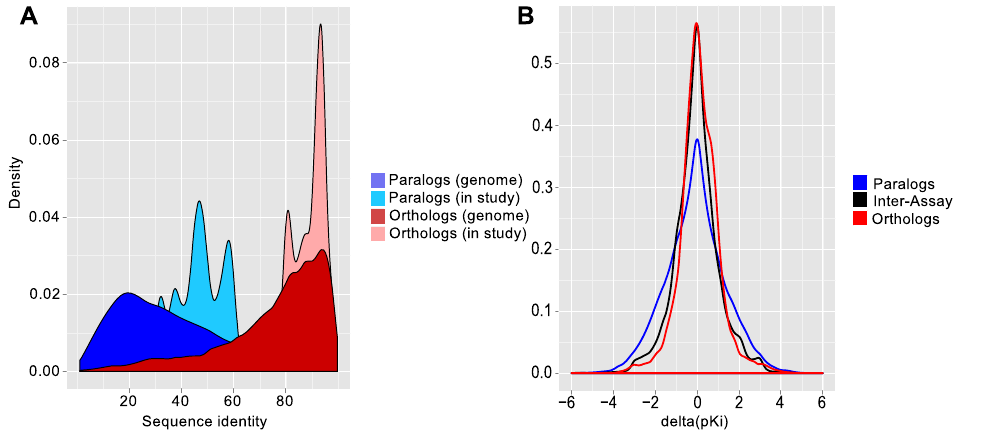
Figure 2. (a) Distributions of pairwise sequence identity between orthologs (red) and paralogs (blue). Distributions in the front represent all pairs retrieved from Ensembl Compara and distributions in the back pairs of targets from our analysis. (b) Distributions of differences in binding affinity between the human target and its rat ortholog (red curve) and distribution of differences in binding affinity between human paralogs (blue curve). For comparison, the distribution of inter-assay differences is outlined (black